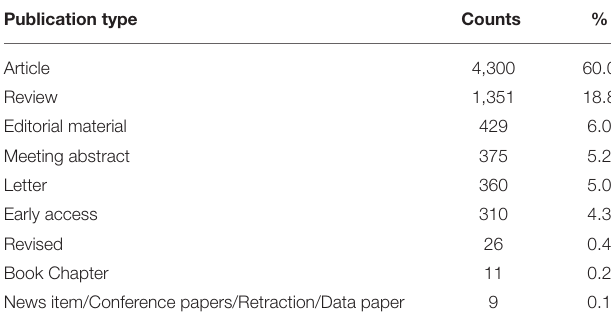
TABLE 1 | Summary of all literature initially included in the